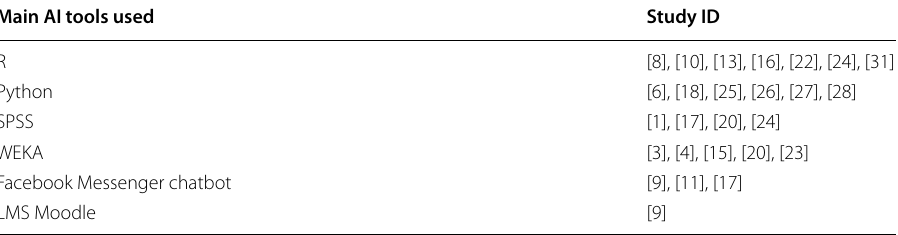
Table 4 AI software tools used by the reviewed studies Main AI tools